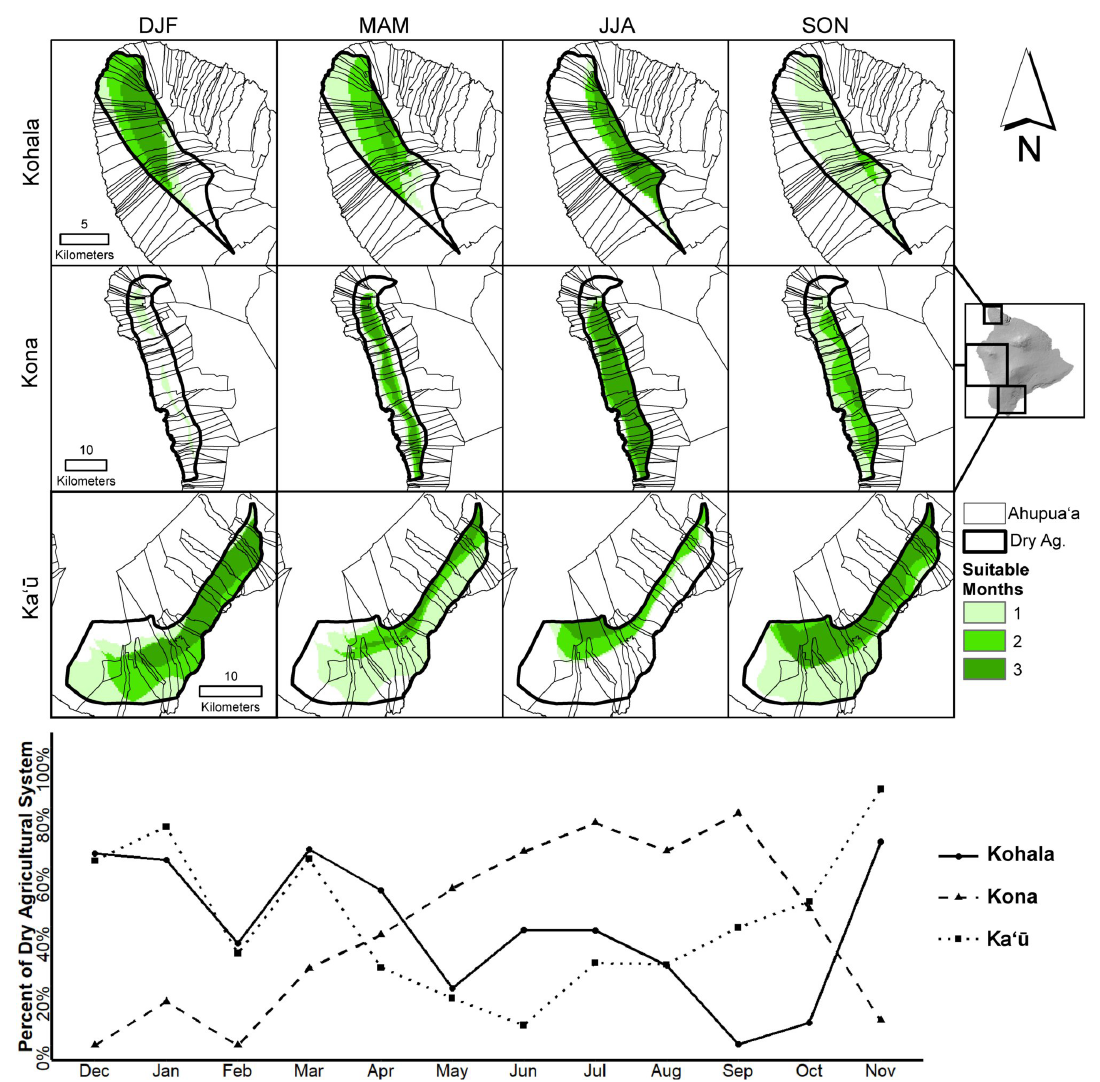
Fig. 5 . Maps of seasonally shifting optimal conditions for ʻ uala (sweet potato, Ipomea batatas ) establishment in the Kohala, Kona, and Ka ʻū field systems using monthly criteria Tmean > 18 °C and P > 90 mm. Monthly data are binned for visual simplicity while the graph below indicates percentage of each field system that is cultivable in each